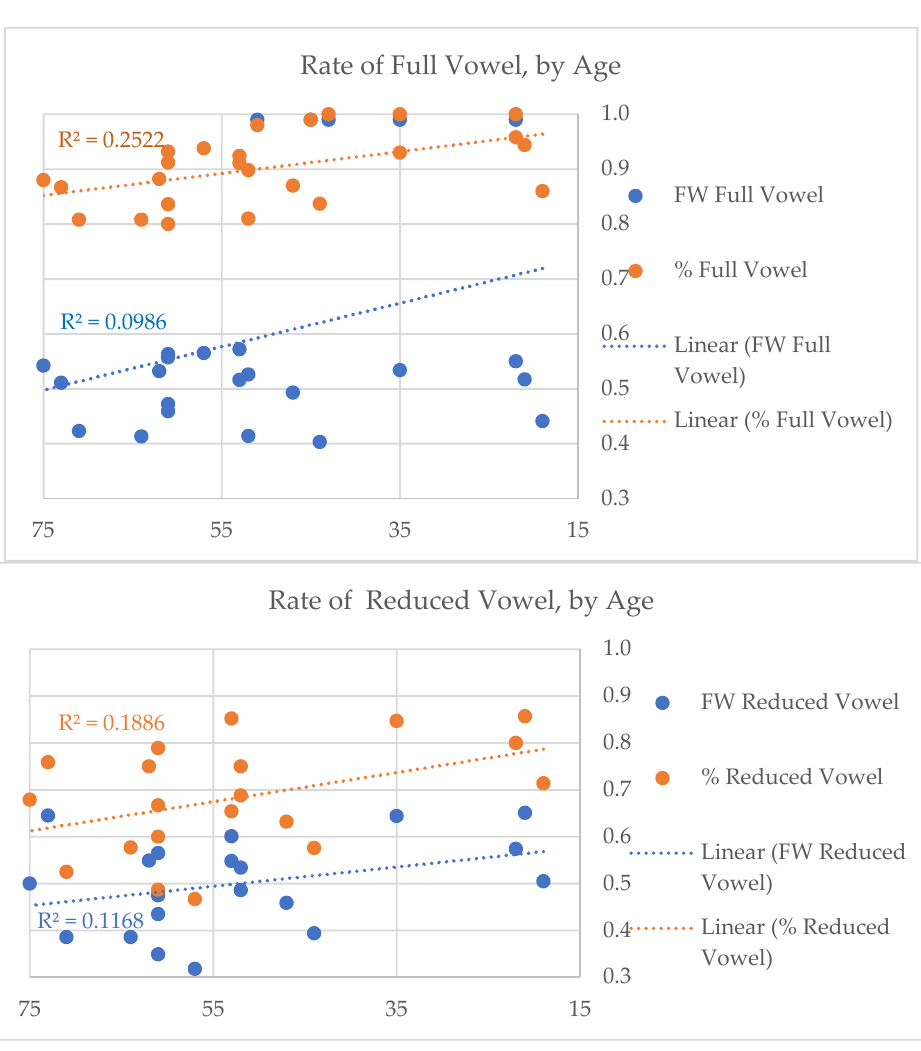
Figure 3. Scatterplots of Speakers for rate of Full vs. Reduced&Deleted ( top , n = 2477, of which 2189 included in model) and Reduced vs. Deleted ( bottom , N = 815). Speakers’ age is on the x -axis.